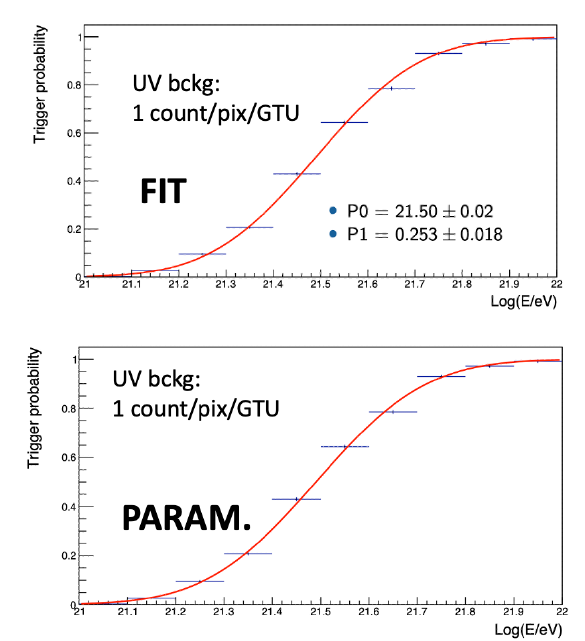
Figure 6. Top: e ffi ciency curve obtained by fitting the simulated data points with equation (2) for the UV background level of 1 count / pix / GTU. Bottom: e ffi ciency curve derived through the parametrization of the P 0 and P 1 dependence as shown in Fig. 5 for the same background